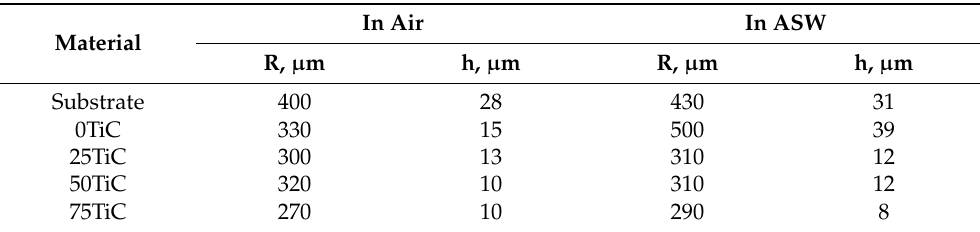
Table 3. Sizes (radius, R, and depth, h) of wear craters of the coatings and steel substrate after impact testing in air and in